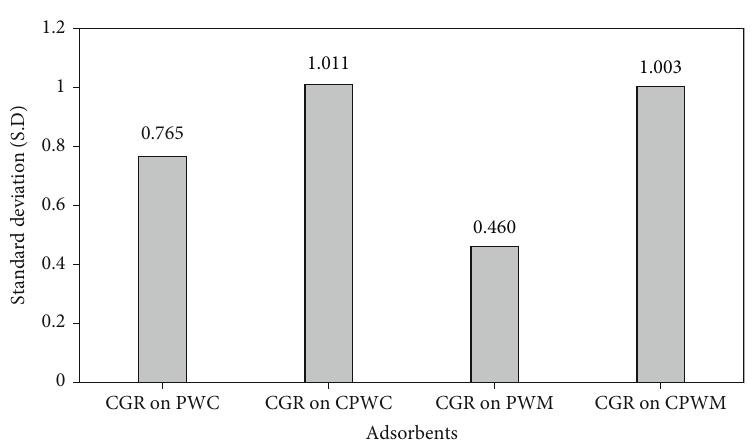
Figure 14: Study of standard